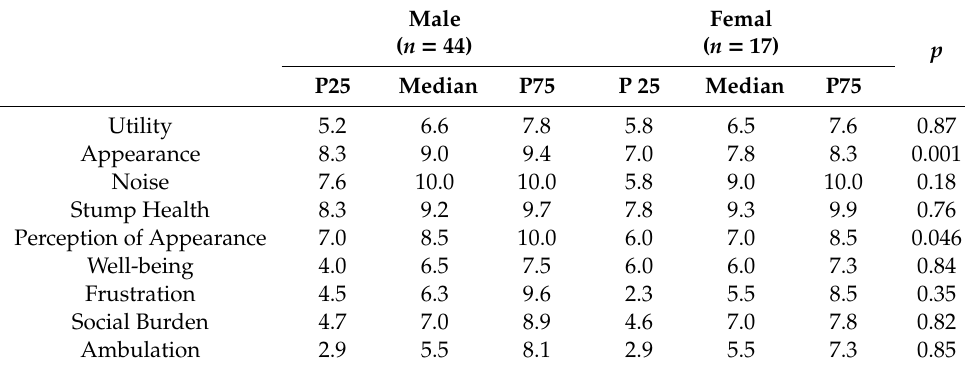
Table 3. PEQ domain levels in relation to gender.